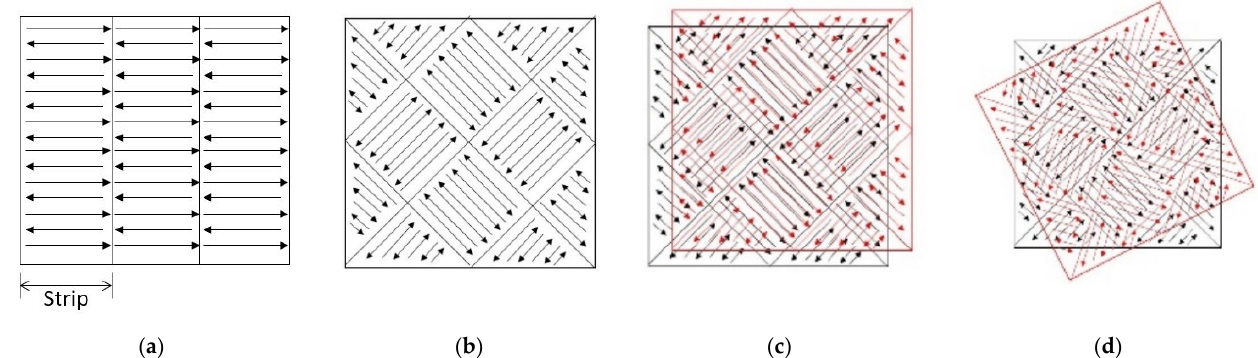
Figure 1. Illustration of the ( a ) “strip scan strategy”; ( b ) “island scan strategy” at single layer; ( c ) displacement between layers; ( d ) rotation between layer. The black config represents the scan strategy of nth layer and the red config represents the scan strategy of (n + 1)th layer.